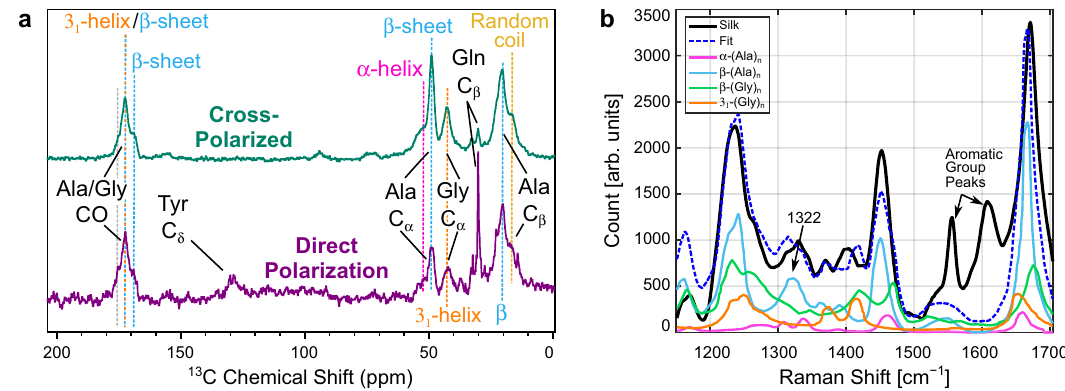
Fig. 5 Silk nuclear magnetic resonance (NMR) results and polypeptide spectral superposition. a Comparison of cross-polarized (teal) and direct- polarization (purple) 13 C MAS NMR spectra of Loxosceles dragline silk. Typical peak positions for Ala and Gly residues for different secondary structures in dashed lines, with blue, orange, pink, and yellow colors representing β -sheet, 3 1 -helix, α -helix, and random coil. Peak assignments based on comparisons to previously published data on silk are given in Table 1. b Comparison of pseudo-unpolarized Raman spectra from purely nano fi brillar spider silk (black line) and model polypeptides (colored solid lines 69,71 , blue: β -(Ala) n , green: β -(Gly) n , orange: 3 1 -helix, pink: α -helix). The blue dashed line fi ts the silk spectrum with a linear combination of polypeptide spectra. Table 1 Comparison of observed 13 C shifts and known values for amino acids in a given secondary